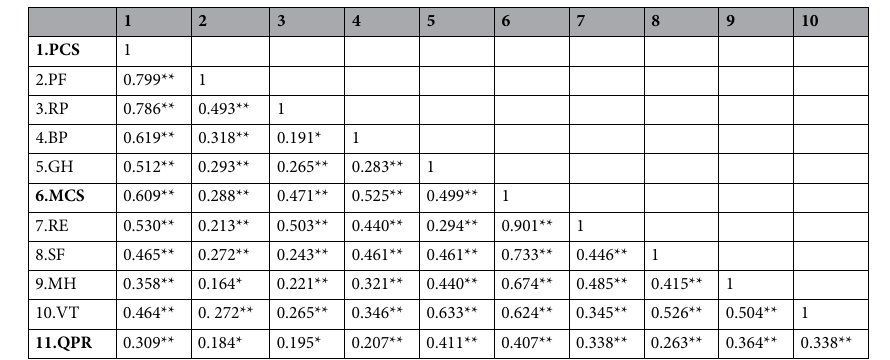
Table 3. Variables of the study during the pandemic ( n = 172). * p < 0.05, ** p <